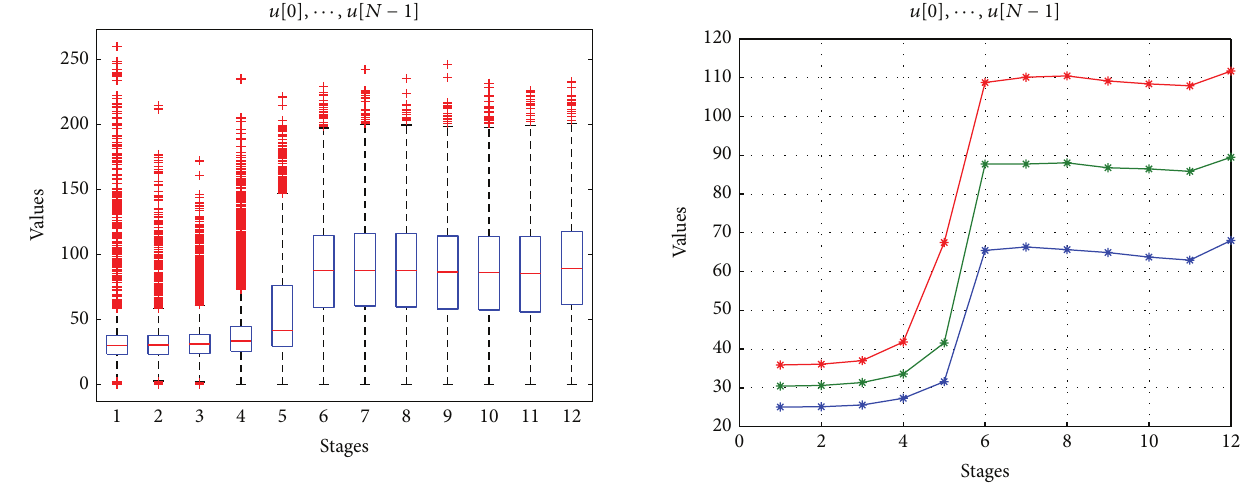
Figure 1: Case 1, box-plots for first product optimal orders.